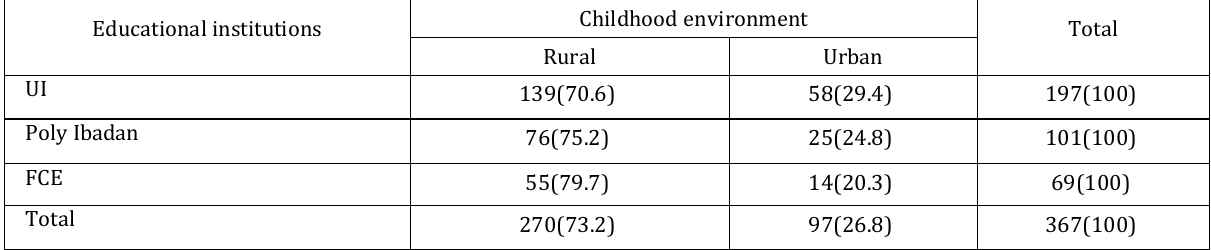
Table 7. Type of house lived in before 12 years of age (source: Authors’ fieldwork data analysis, 2016) Educational institutions Type of house lived before 12 years of